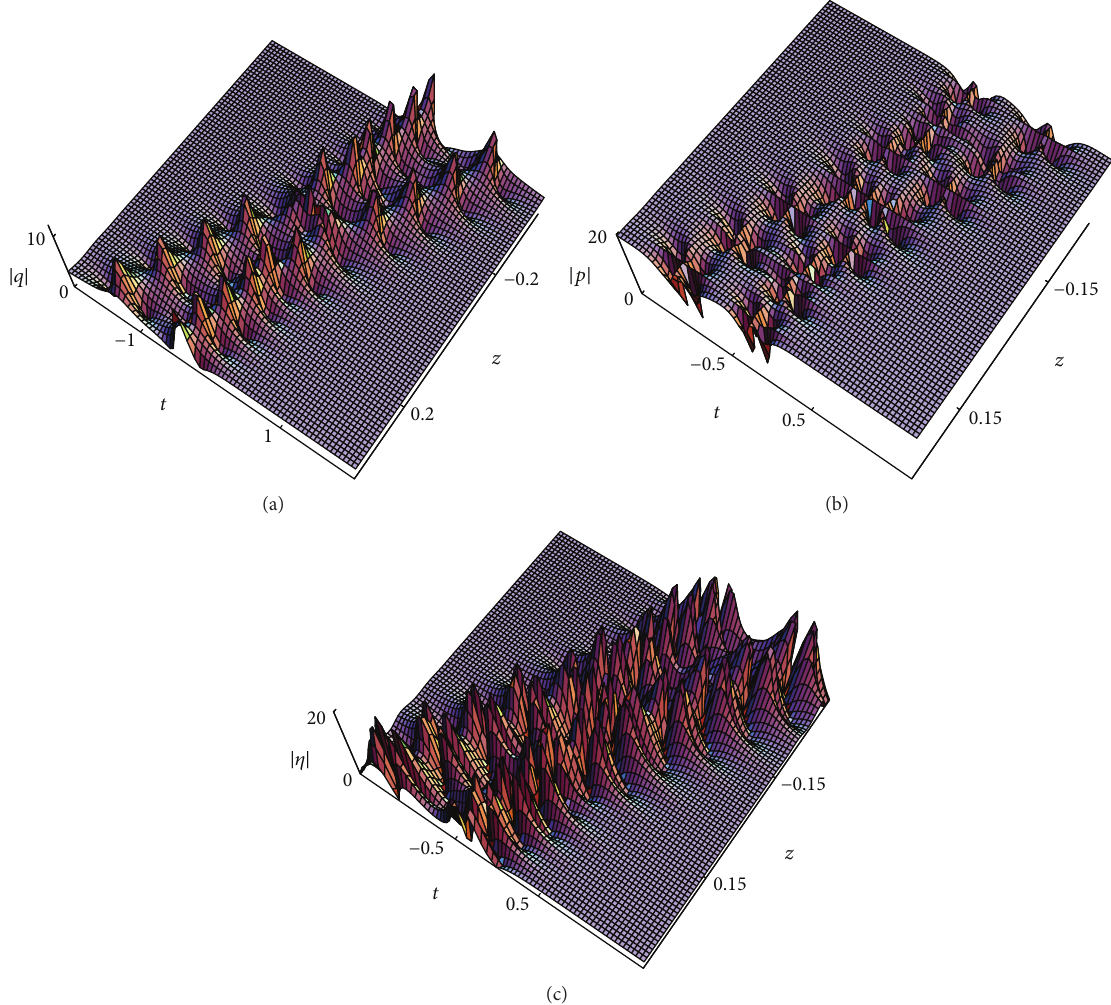
Figure 9: The parameters adopted here are 𝜆 1 = 5𝑖 , 𝜆 2 = 4𝑖 , 𝑞 𝑐 = 3 , 𝜔 𝑐 = 2 , 𝜅 𝑐 = 1 , 𝜔 = 0.5 , and 𝜏 = 0.1